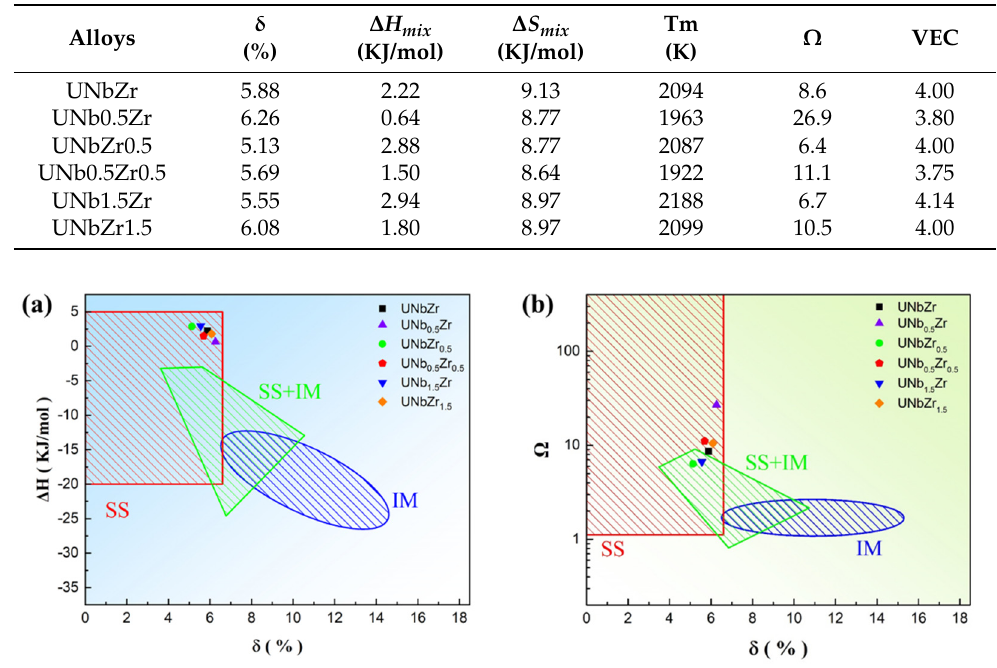
Figure 2. The distribution of the entropy alloy in the ternary U-Nb-Zr in the relationship diagram of ( a ) δ - ∆ H and ( b ) δ - Ω (SS: solid solution; IM: intermetallic compound).